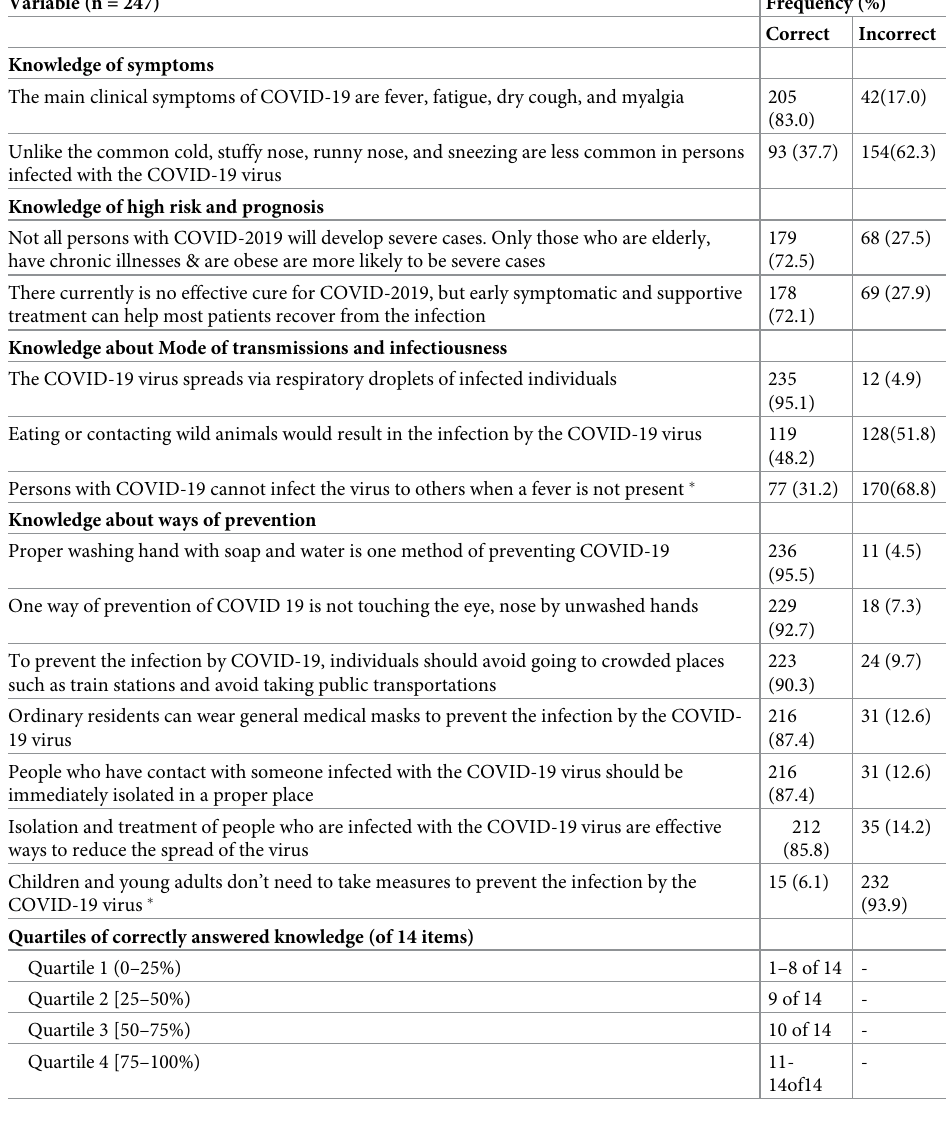
Table 2. Knowledge of COVID-19 among JUMC visitors, Jimma, Ethiopia, March 2020 (N = 247). Variable (n = 247)